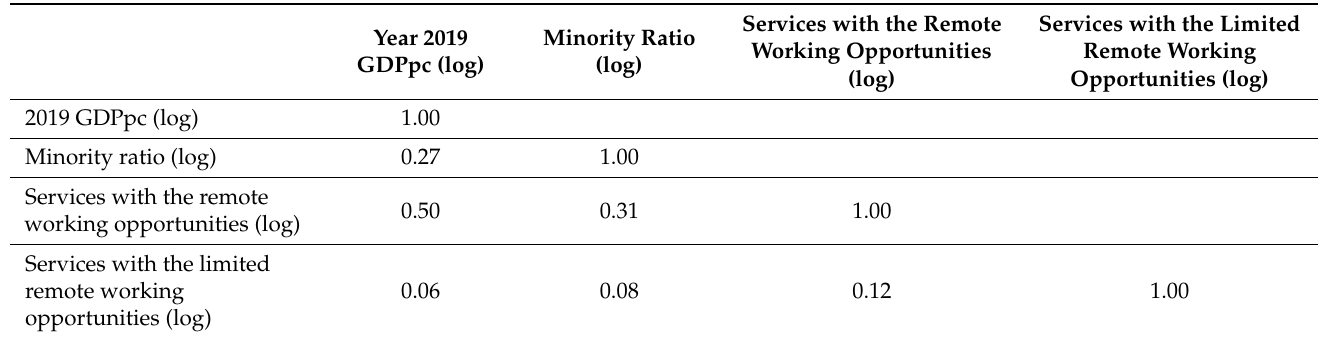
Table A2. Pearson’s correlations between socio-economic characteristics of the US states used in the analysis (see Table